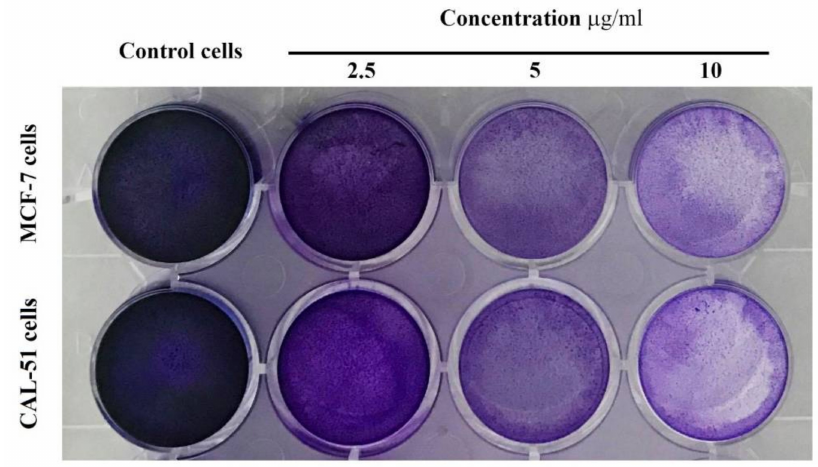
Figure 11. Colony formation assay of TAM/RES–LbL-LCNPs nanoparticles in cancer cell lines. MCF-7 cell line (upper line) and CAL-51 cell line (lower lane).